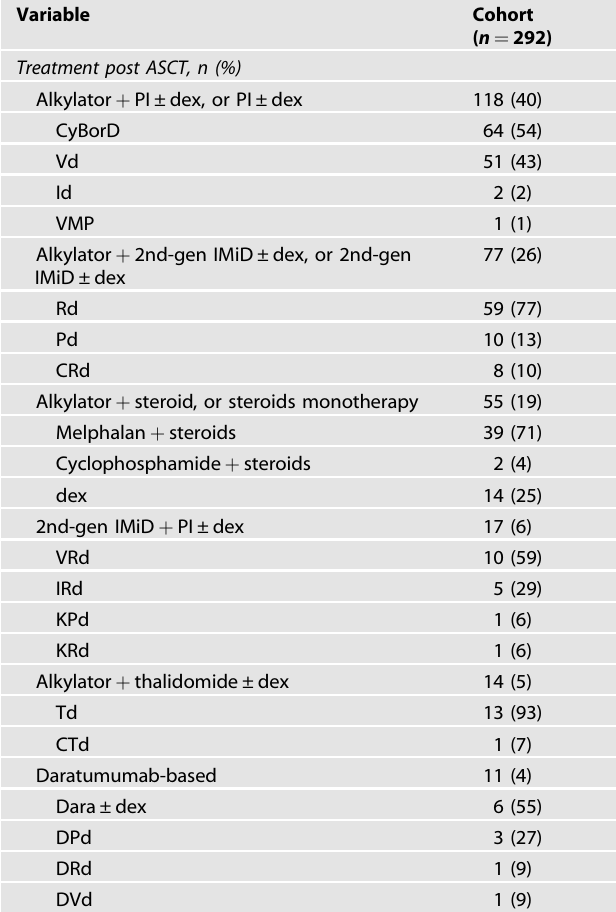
Table 2. Details of treatment post